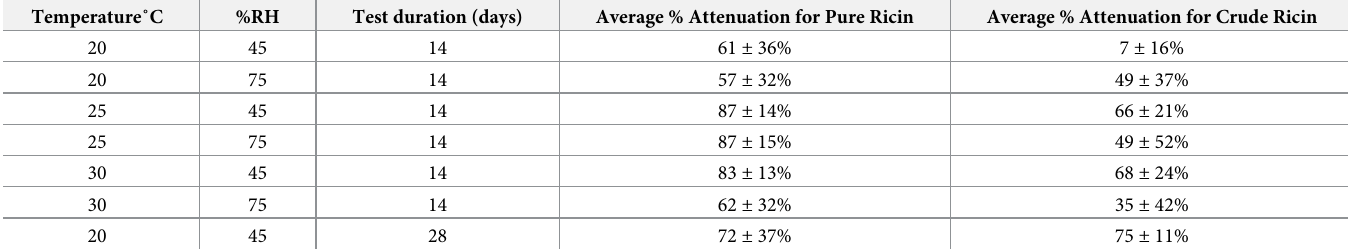
Table 3. Average percent attenuation obtained for each environmental condition at 14 and 28